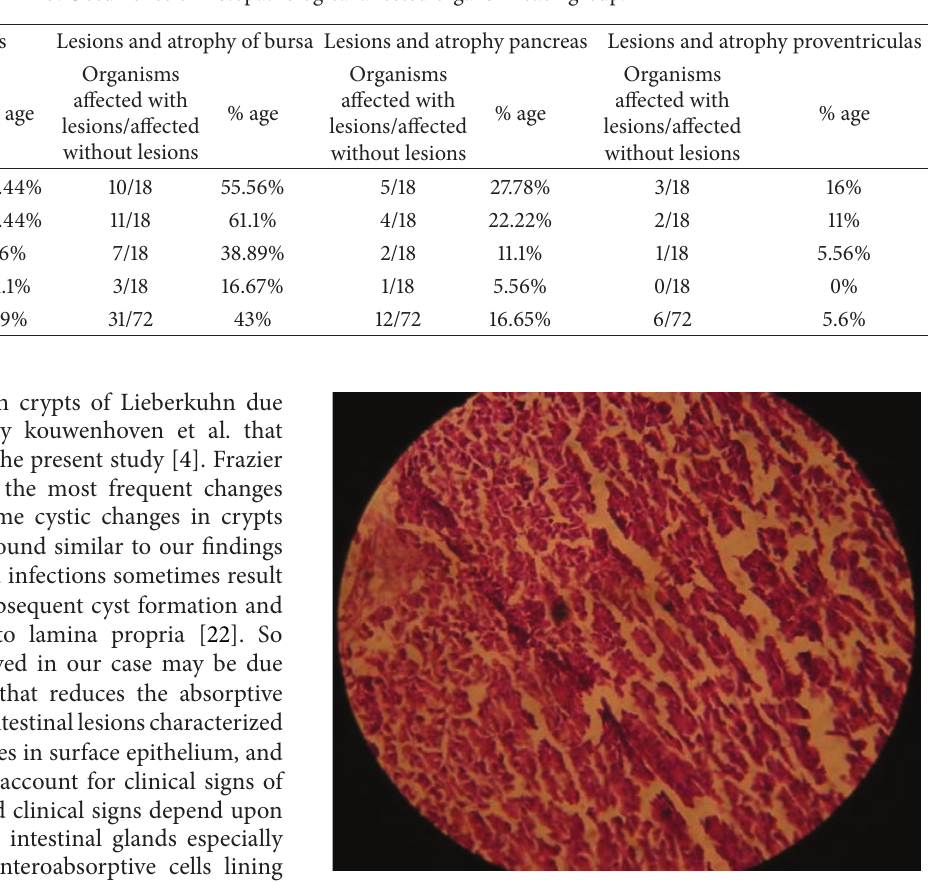
Table 3: Occurrence of histopathological affected organs in each group.